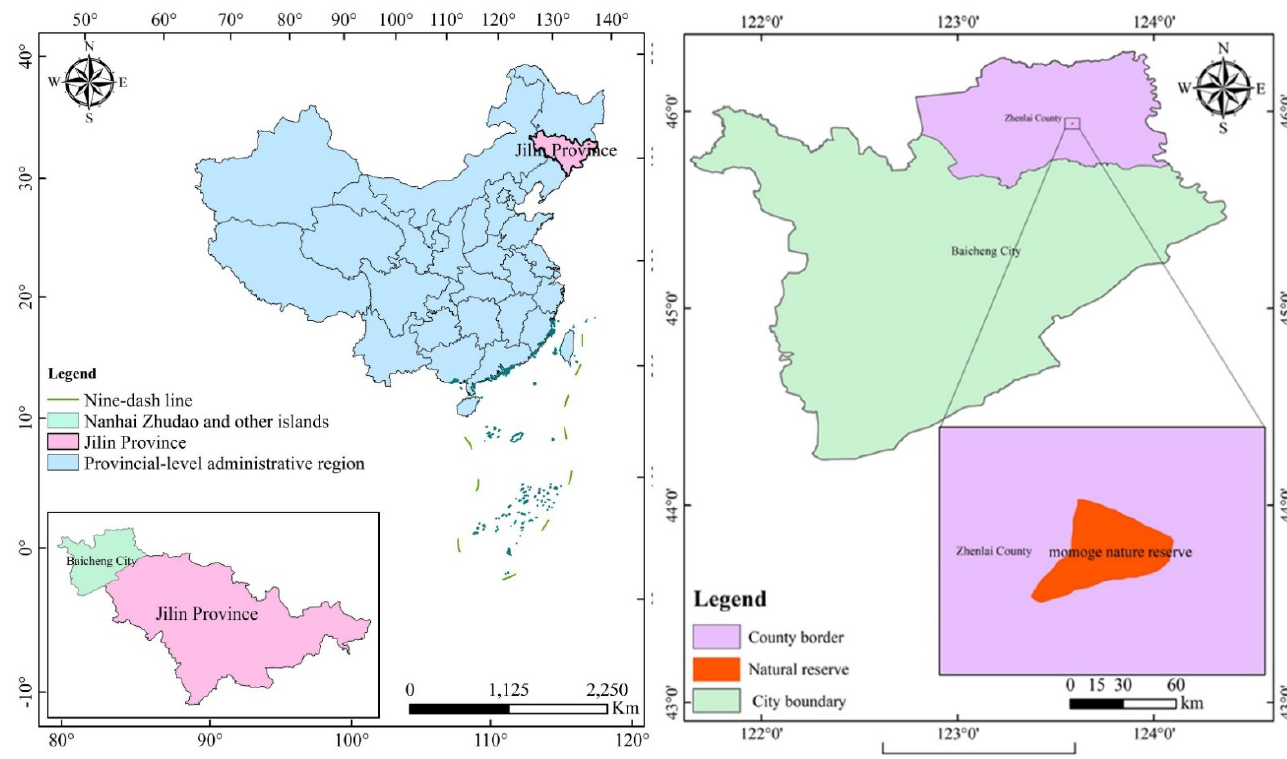
Figure 1. The geographical location of Jilin Momoge National Nature Reserve.